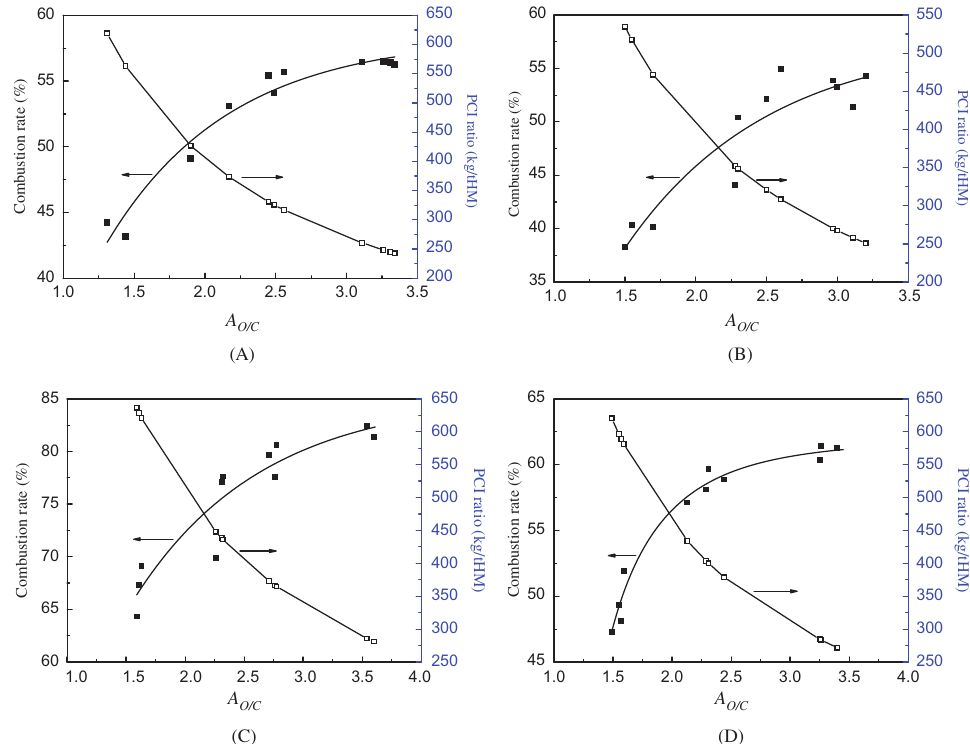
Figure 3: Pulverized coal combustion rate and corresponding PCI ratio with various A O/C.